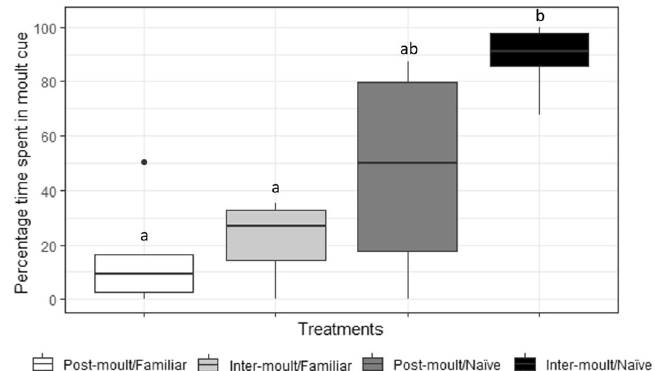
Figure 2. Mean percentage time juvenile Panulirus ornatus spend in choice arena current containing conspecific moulting cues during a 10 min exposure window. Four treatment groups denoted by the response lobsters moult-stage and relationship with moulting lobster, post-moult/familiar (n = 5), inter-moult/familiar (n = 5), post-moult/naïve (n = 6) and inter-moult/naïve (n = 6). Lower case letters indicate significant differences in percentage time spent in moult cues. Central black line in each box represents median